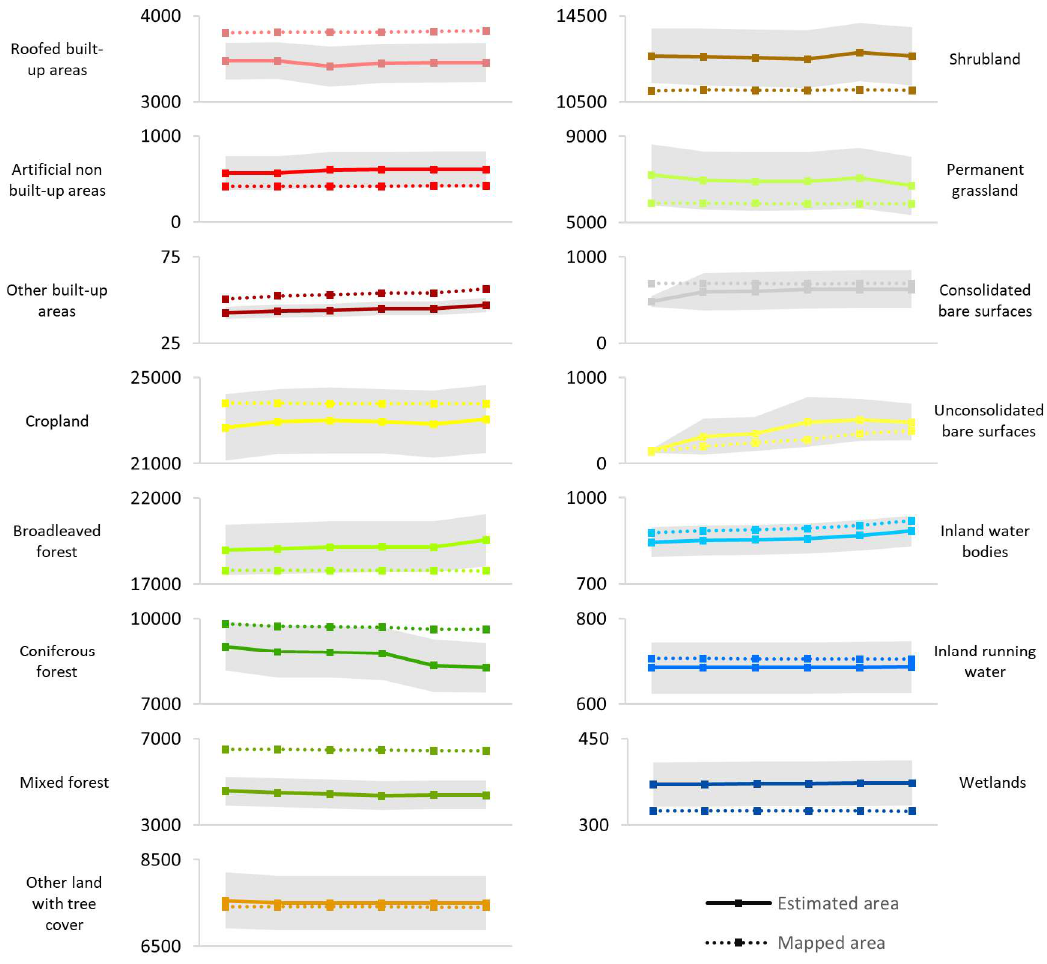
Figure 8. Difference between mapped and estimated area of the land cover classes. All plots present time (from 2010 to 2015) in the x -axis and area (km 2 ) in the y -axis. Shaded areas represent 95% confidence intervals.